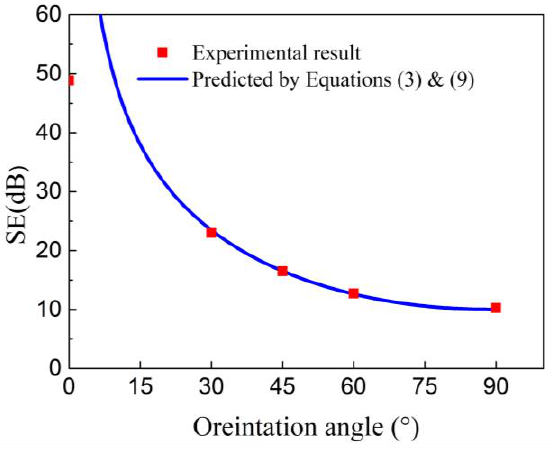
Figure 7. EMI SE of CFRP for experimental and predicted results at the frequency of 10